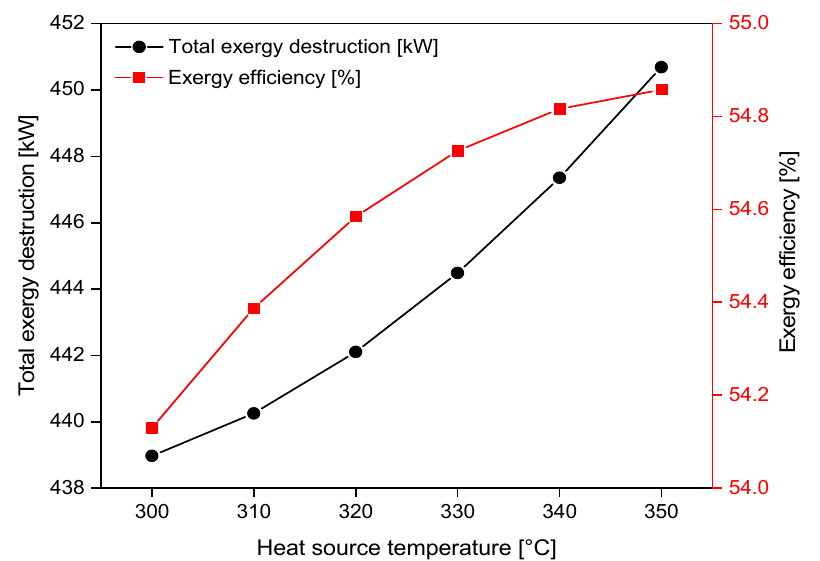
Figure 11. Variation of exergy efficiency and total exergy destruction with heat source temperature in August.